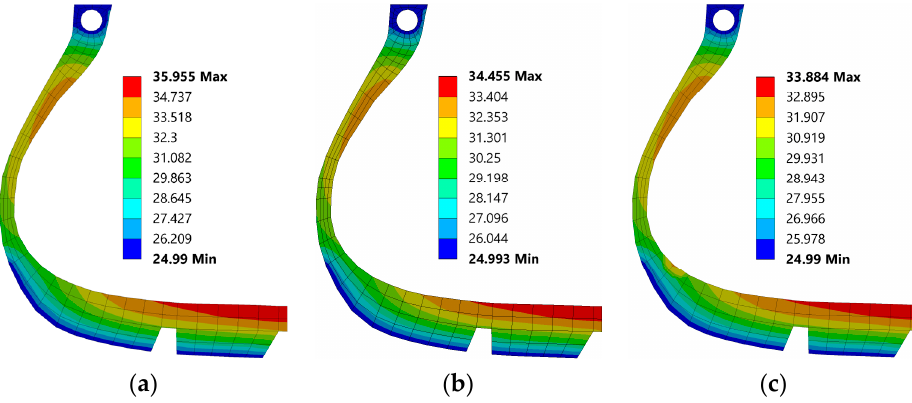
Figure 14. Distribution of temperature within rubber with di ff erent pressures and the loading of 6 kN (unit: °C): ( a ) 28 psi; ( b ) 32 psi; ( c ) 34 psi.